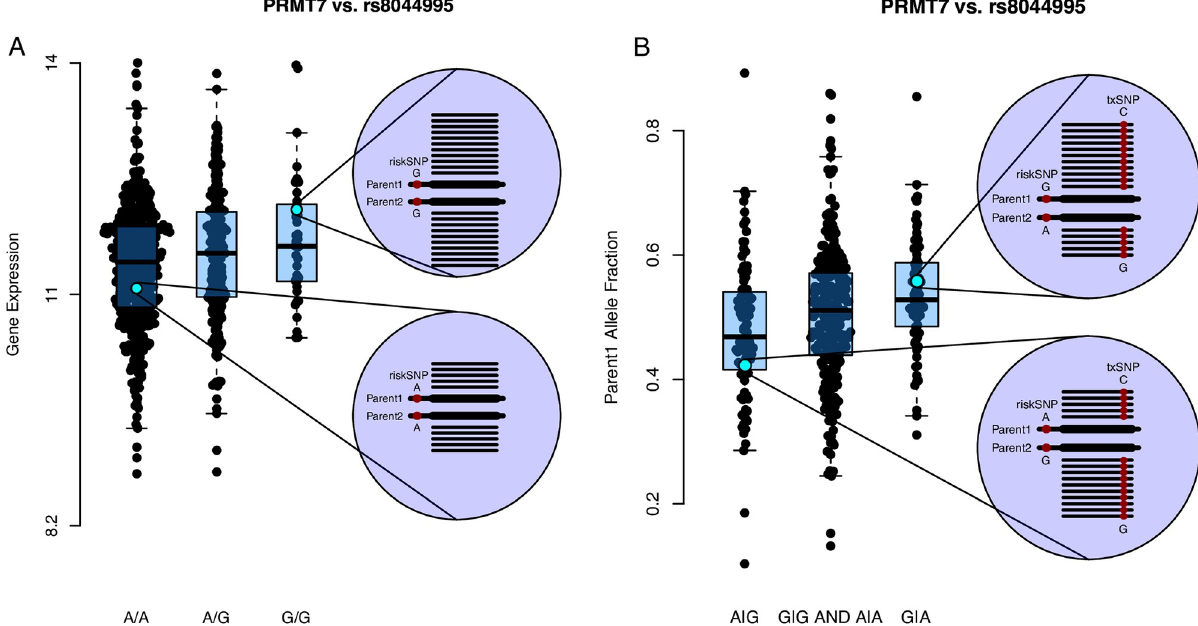
Fig 1. Comparison of eQTL and aeQTL for PRMT7 and the rs8044995 risk-SNP. (A) In a standard eQTL analysis the X-axis (input variable) is the genotype of the risk-SNP and the Y-axis (response variable) is the expression of the gene. (B) aeQTL analysis of the same risk-snp/gene pair. The Y-axis shows the fraction of reads coming from the Parent 1 chromosome in the PRMT7 gene. Only samples with a heterozygous txSNP are included, and in samples with more than one heterozygous txSNP the average fraction is used. The X-axis shows the risk-SNP group: samples that are heterozygote with an A-allele on the Parent 1 chromosome are in group 1, samples that are homozygote (A/A or G/G) are in group 2, and samples with a G-allele on the Parent 1 chromosome are in group 3. The linear regression of these values constitutes the basis of the aeQTL model. The supplementary S2 File provides plots for all gene-SNP pairs that are listed in Table